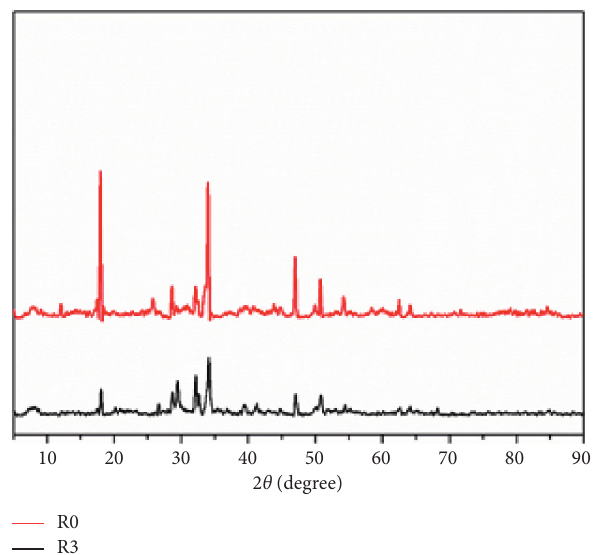
Figure 7: XRD patterns of pure cement paste (R0) and resin modified cement paste